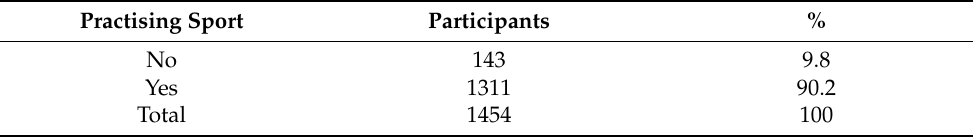
Table 2. Participants practising or not practising